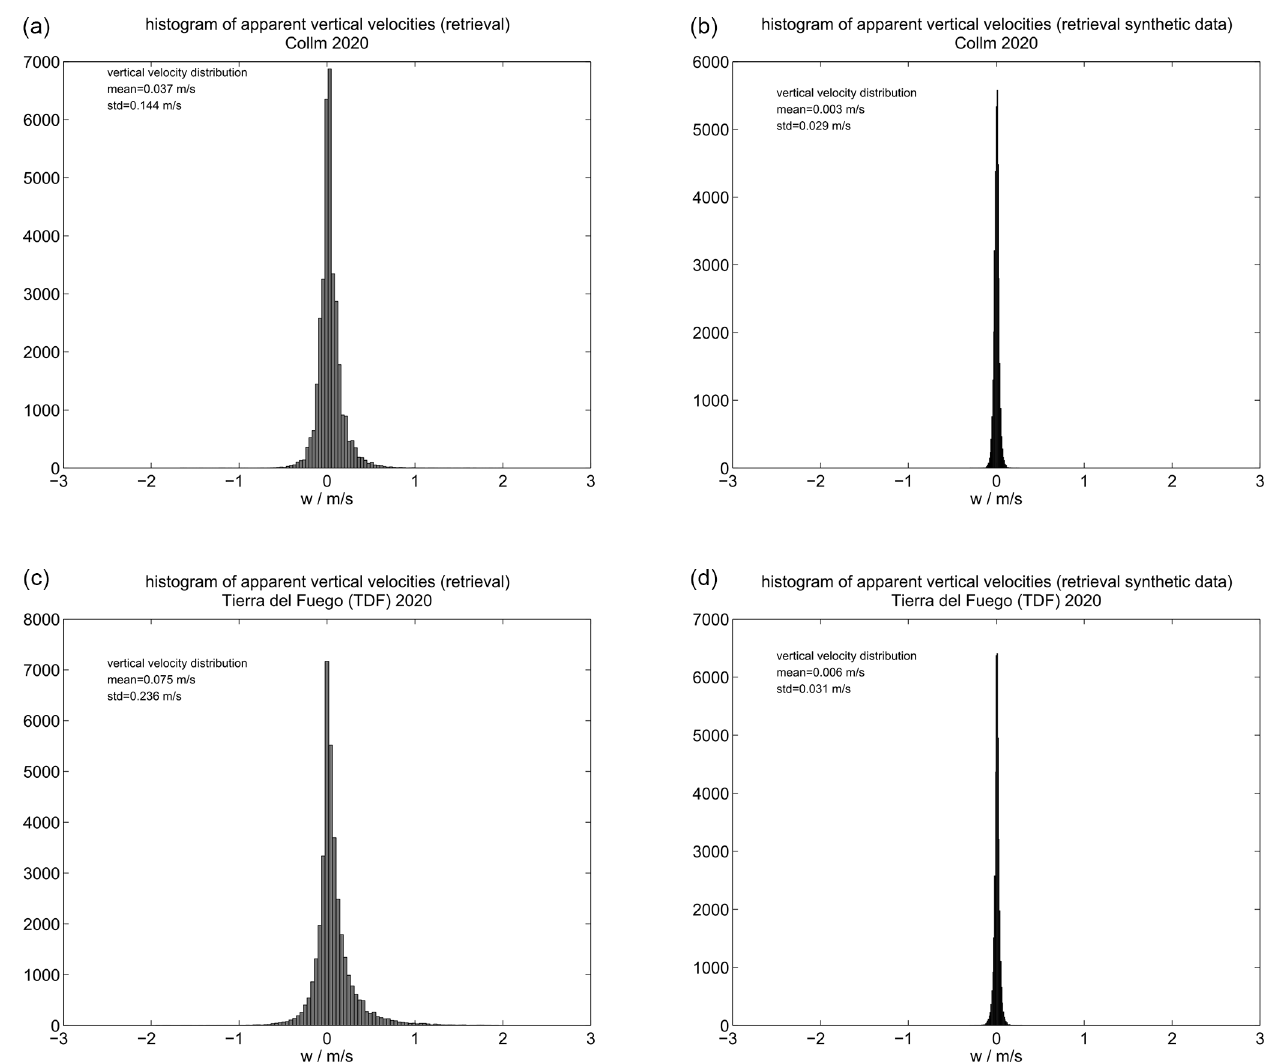
Figure 5. The same as Fig. 1, but the hourly vertical winds are obtained by applying the retrieval algorithm including the spatiotemporal Laplace algorithm. The x -axis scale or w -axis scale was reduced to show the remaining